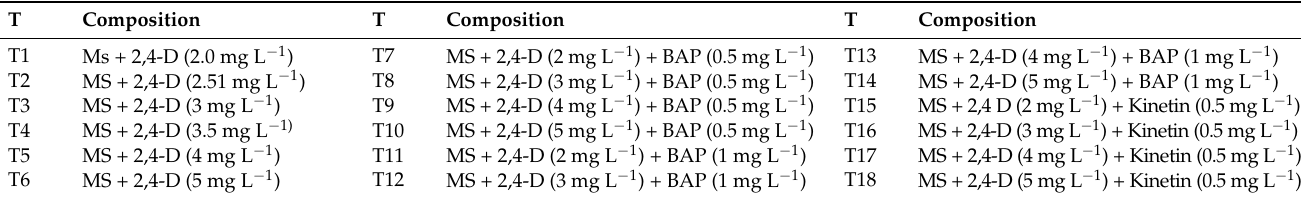
Table 1. Different Media compositions for callus induction.